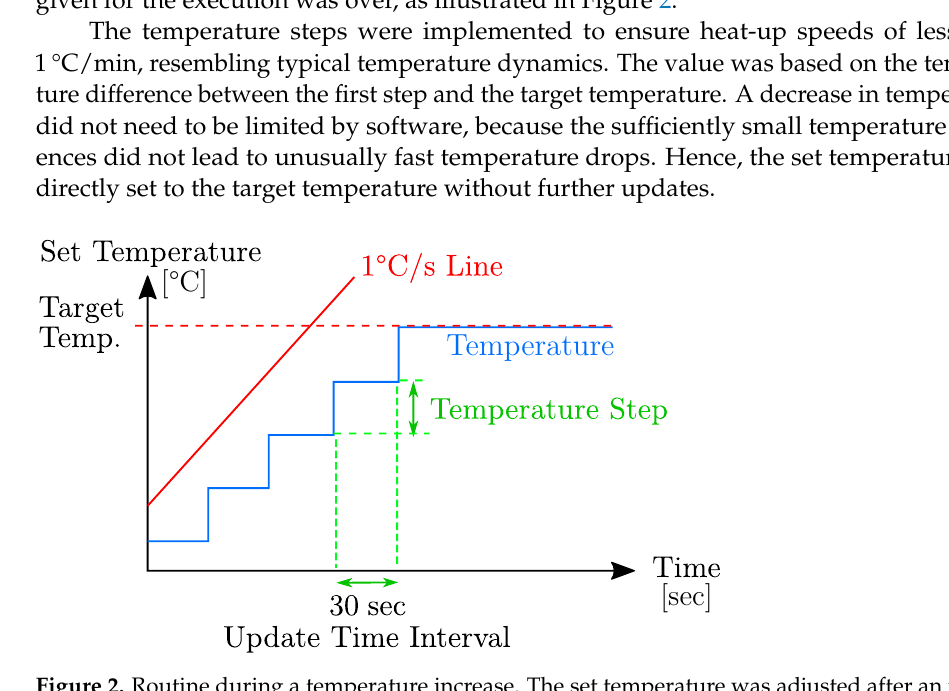
Figure 2. Routine during a temperature increase. The set temperature was adjusted after an update time interval of 30 sec. The routine was applied until the target temperature was reached.